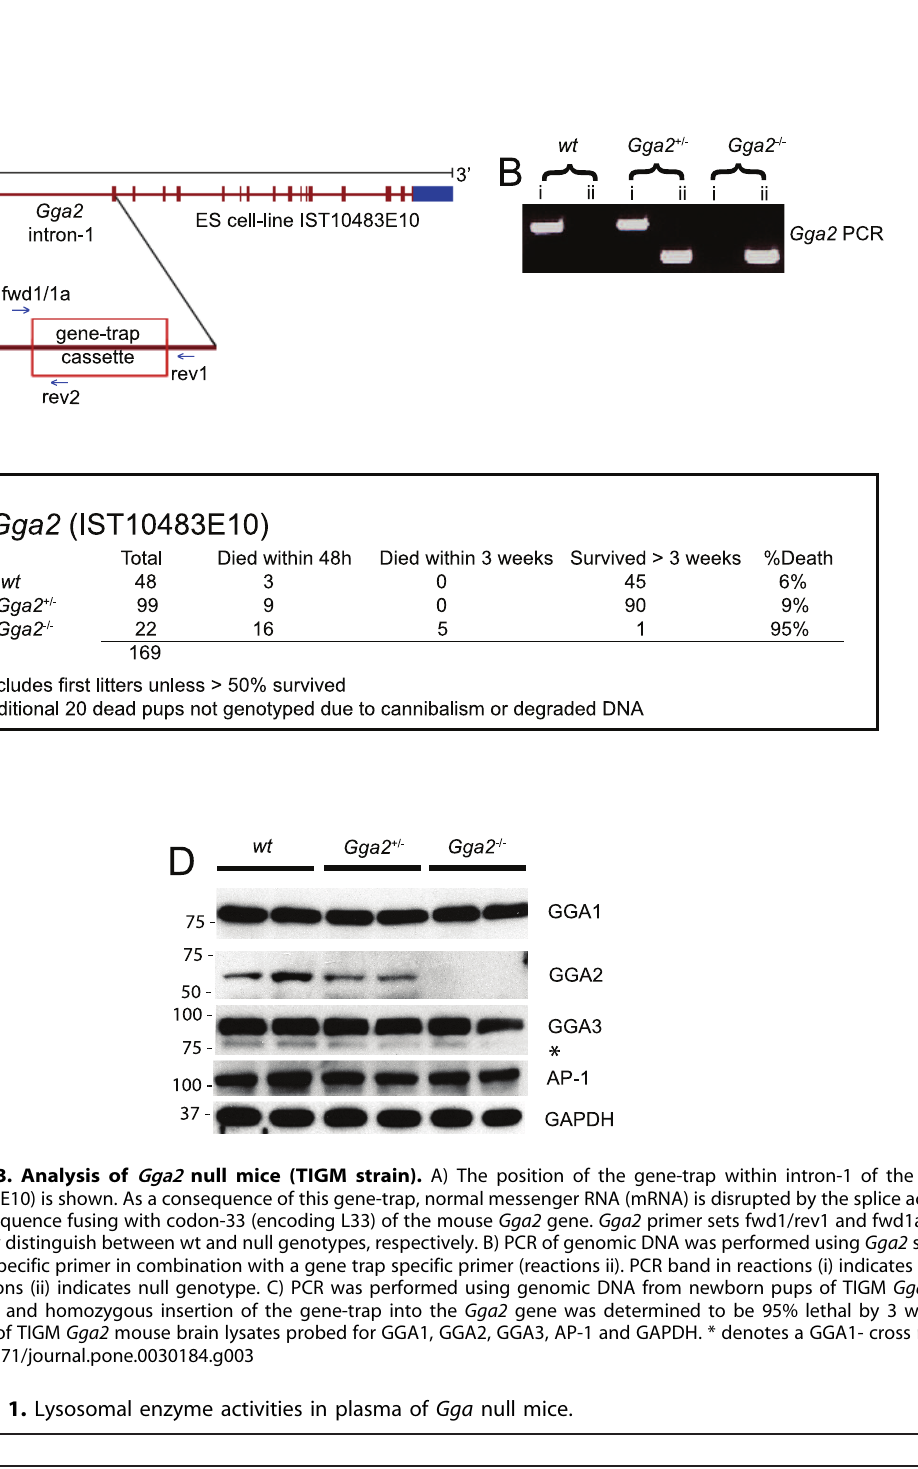
Table 1. Lysosomal enzyme activities in plasma of Gga null mice.